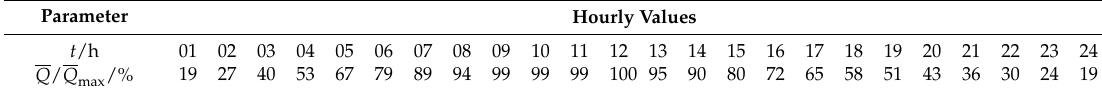
Table 8. Normalized daily profile of total anthropogenic heat emissions from the LUCY model.